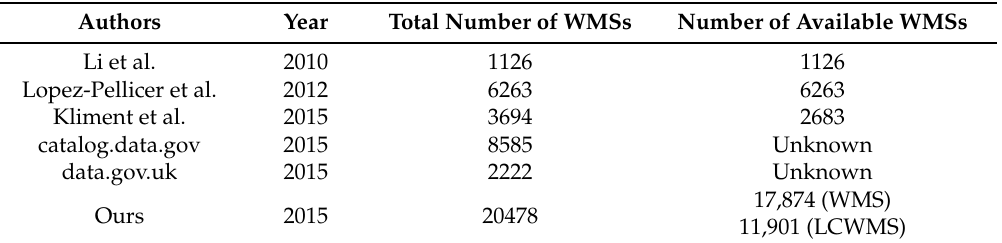
Table 7. Comparison of the number of web map services (WMSs) found by various methods. Authors Year Total Number of WMSs Number of Available WMSs Li et al. 2010 1126 1126 Lopez-Pellicer et al. 2012 6263 6263 Kliment et al. 2015 3694 2683 catalog.data.gov 2015 8585 Unknown